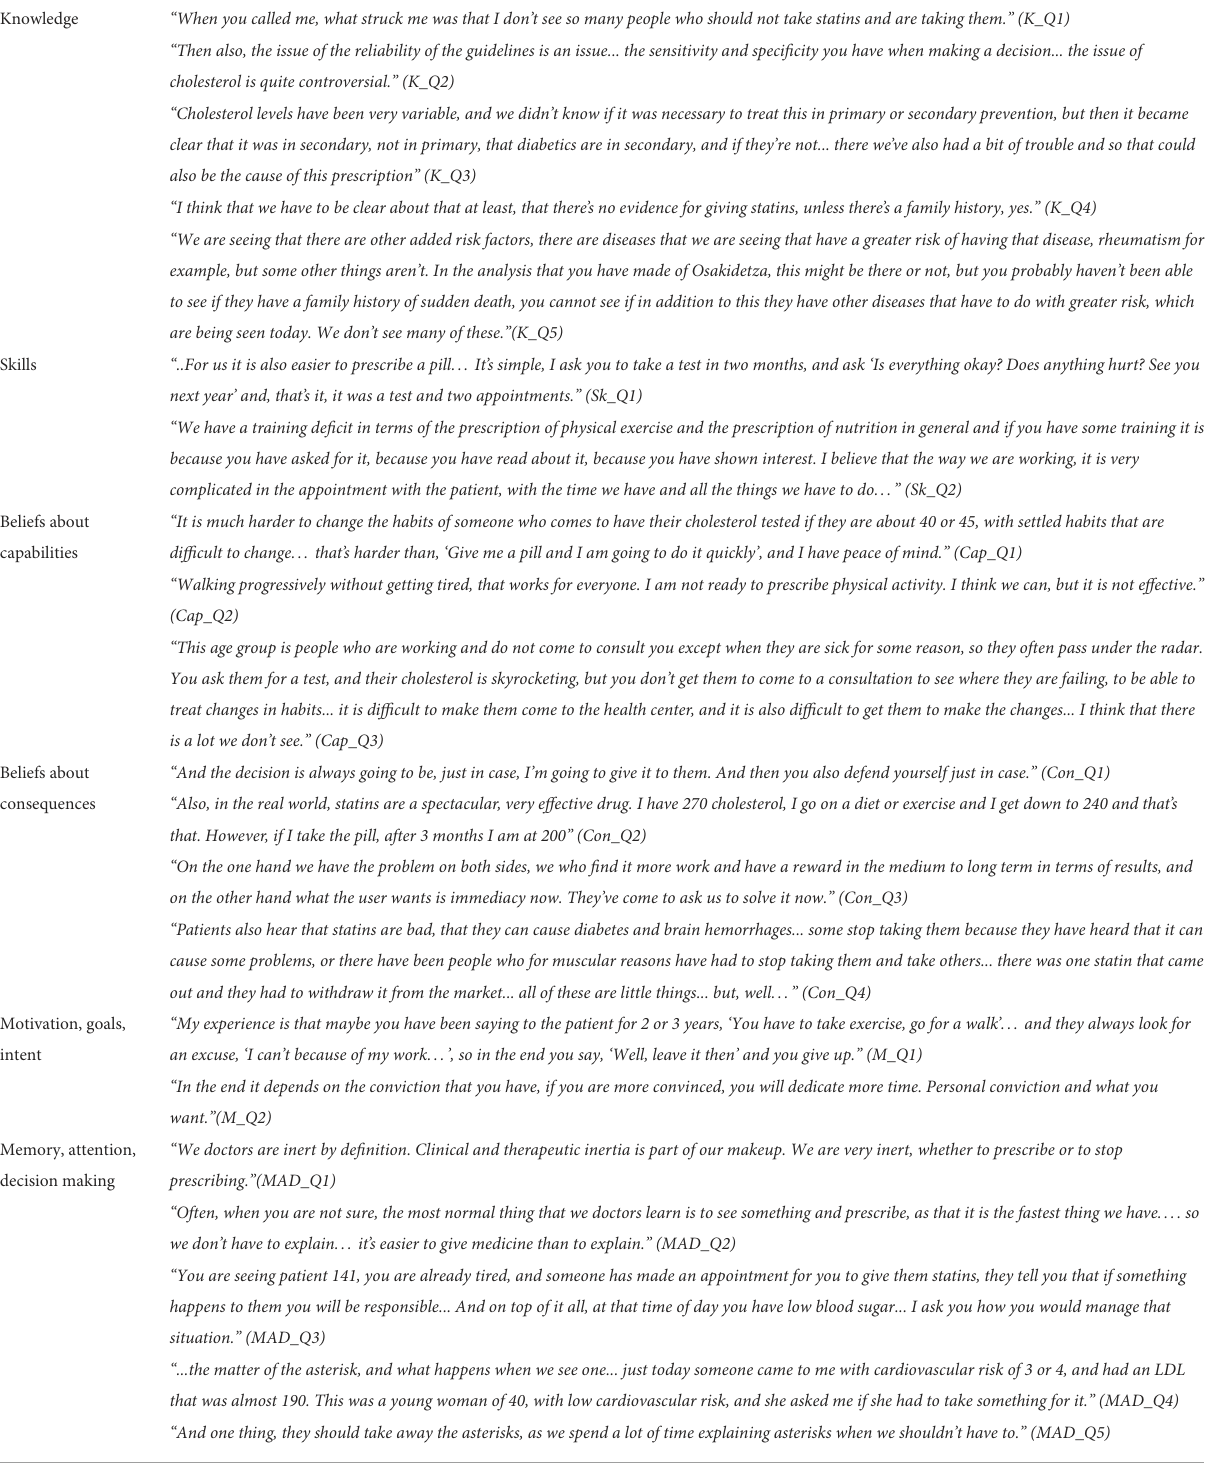
TABLE 1 Quotes extracted from FPs discussion groups by theoretical domains framework determinant dimensions. TDF dimension Extracted